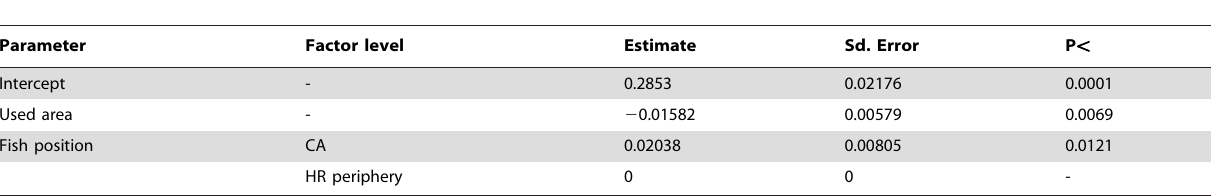
Table 2. Solution for fixed effects (parameter estimates with corresponding standard errors and p-values for the final LMM model).